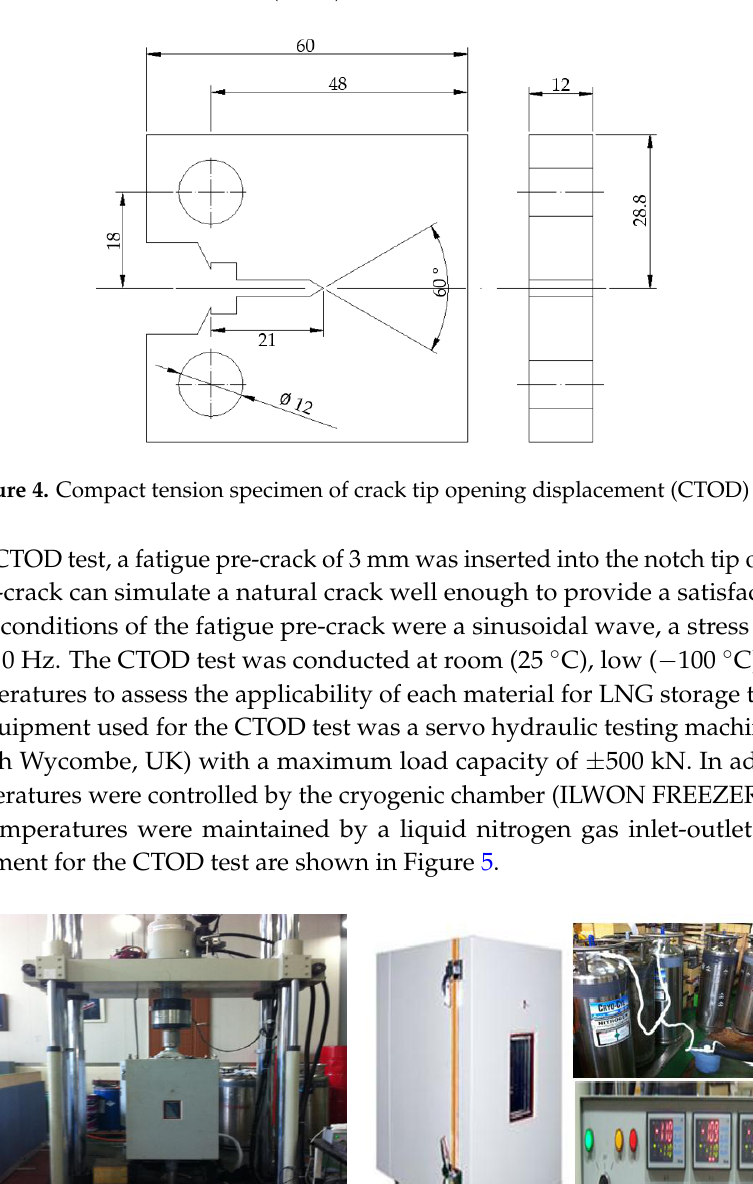
Figure 5. Test equipment: ( a ) servo hydraulic testing machine; ( b ) temperature control system.